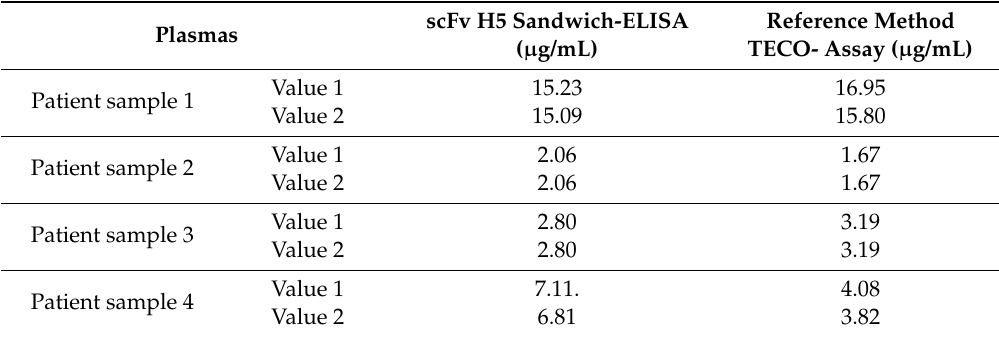
Table 1. Sandwich ELISA assay of total adiponectin in human plasma using scFvH5 as a captor. Plasmas